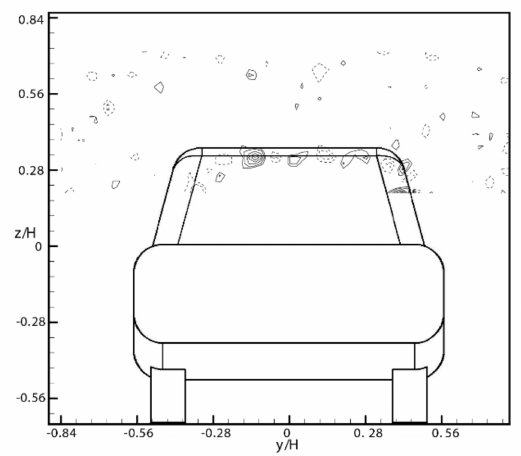
Figure 10. Iso-contours of instantaneous stream-wise vorticity, ω x in the y–z plane at x/H = − 0.7. Minimum and incremental values of vorticity are ω x,min = − 185.343 s − 1 , 215.220 s − 1 , and − 1 , respectively. ∆ ω x = 143.058 s